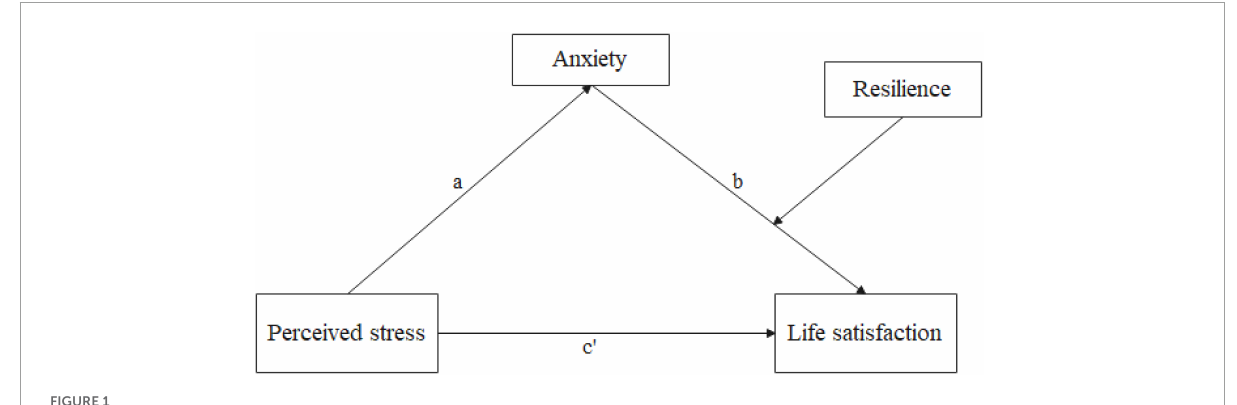
FIGURE1 The hypothesized moderated mediation